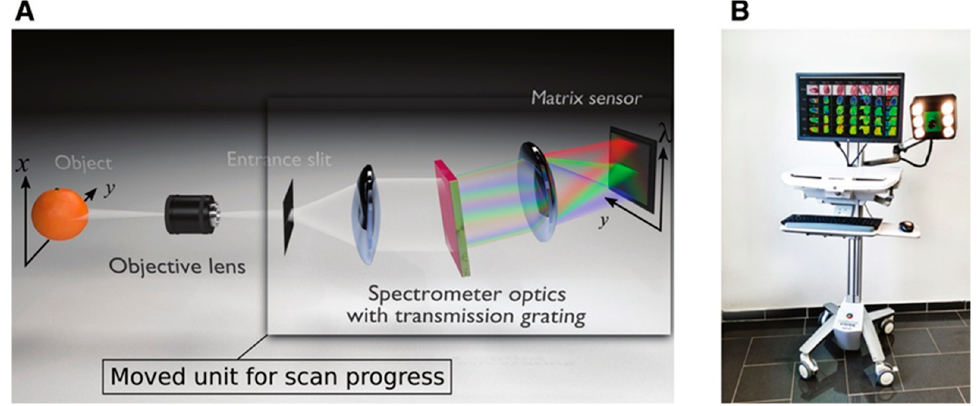
Figure 4. Push broom TIVITA tissue camera, ( A ) schematic diagram of push broom spectroscopy system; ( B ) hyperspectral camera mounted on a medical vehicle [23]. system; ( B ) hyperspectral camera mounted on a medical vehicle